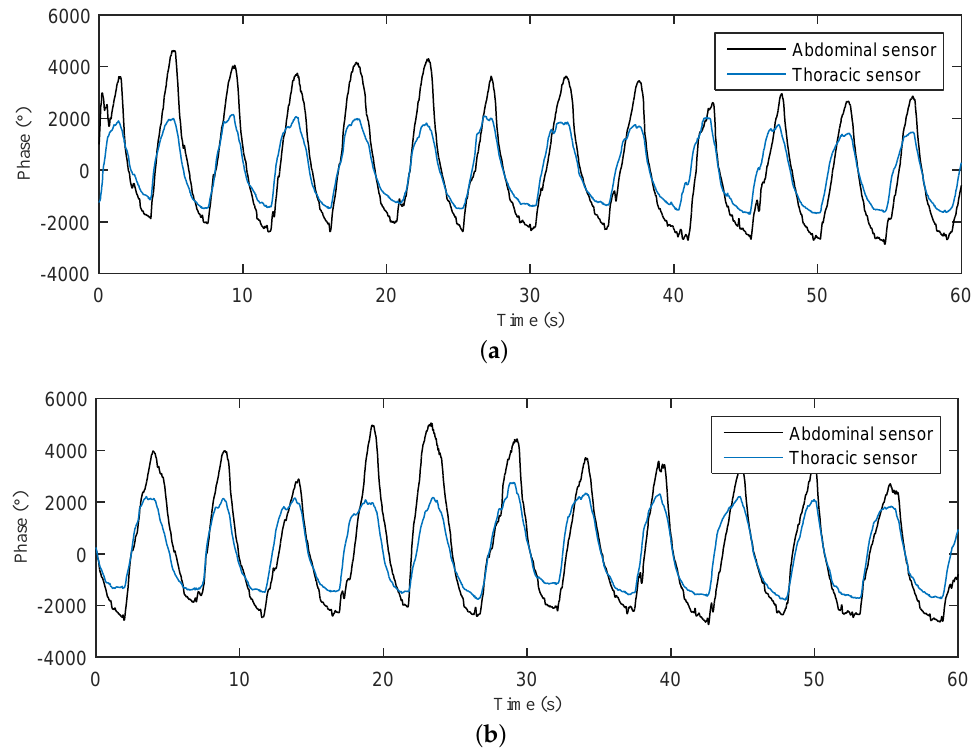
Figure 6. Sample plots of real raw data acquired from the thoracic and abdominal sensors of two different test subjects. ( a ) volunteer No. 1; ( b ) volunteer No. 2.